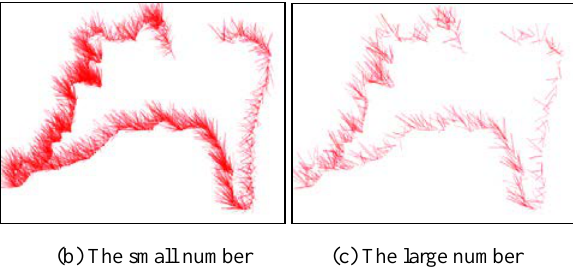
Figure 6. Rendering results with various number of cloud drops